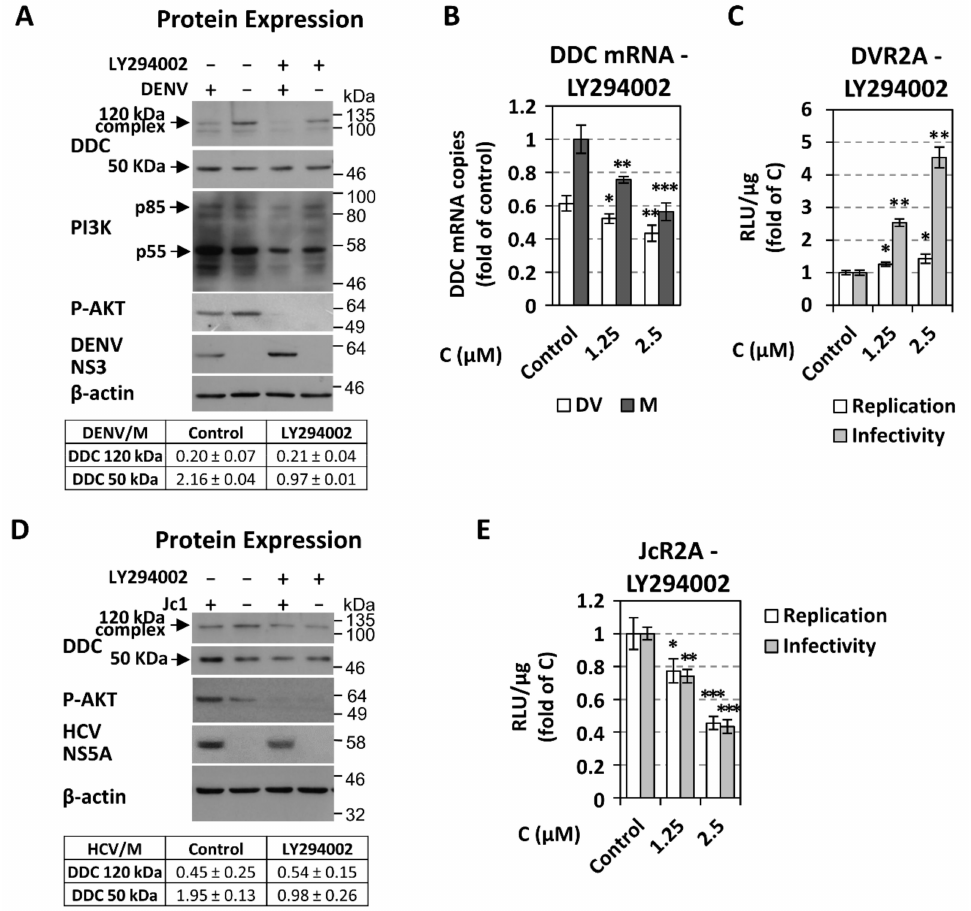
Figure 7. E ff ect of PI3K inhibition on DENV- and HCV-mediated DDC protein regulation in infected cells. ( A – C ) Huh7 cells inoculated with DV-2 16,681 non-reporter (DENV, MOI = 1) or reporter (DVR2A, MOI = 0.1) virus for 4 h, were treated with di ff erent concentrations of the PI3K inhibitor LY294002 for 48 h, respectively. ( A ) (Top) Western blot analysis of lysates of DENV- or mock-infected cells, treated or not with 2.5 µ M LY294002, using anti-DDC-CT, anti-PI3K, anti-P-AKT, anti-DENV NS3, or anti- β -actin antibodies. β -actin was used as loading control. Representative experiments of three independent repetitions are shown. (Bottom) Image quantification of DDC signals (mean values from